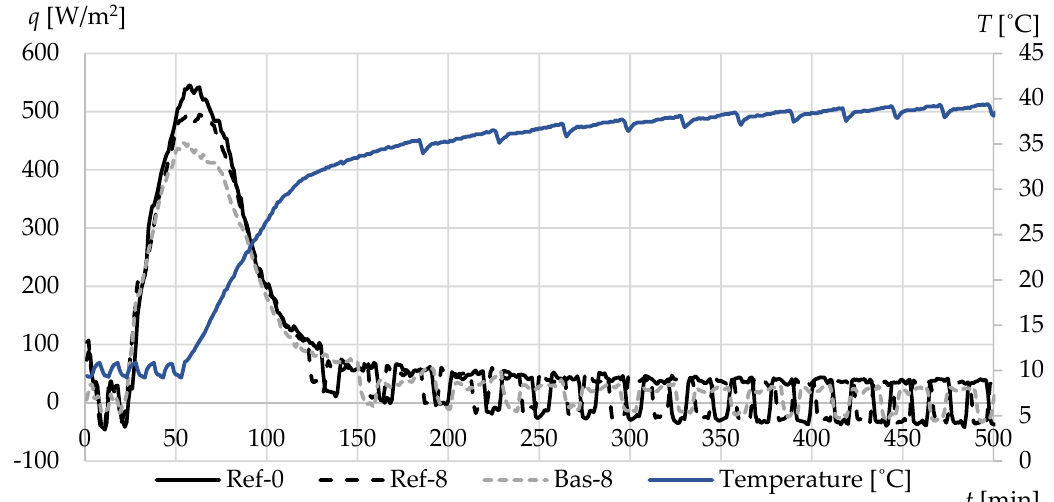
Figure 12. The average heat fluxes on the surface of specimens during heating from 10 to 40 °C.